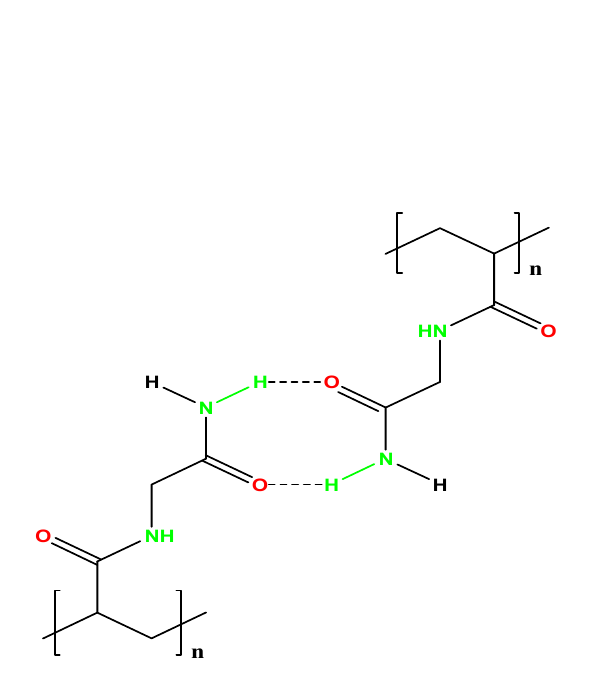
14 of 53 Figure 3. PNIPAAm chains (black) surrounded by water molecules (blue) as a function of tempera-